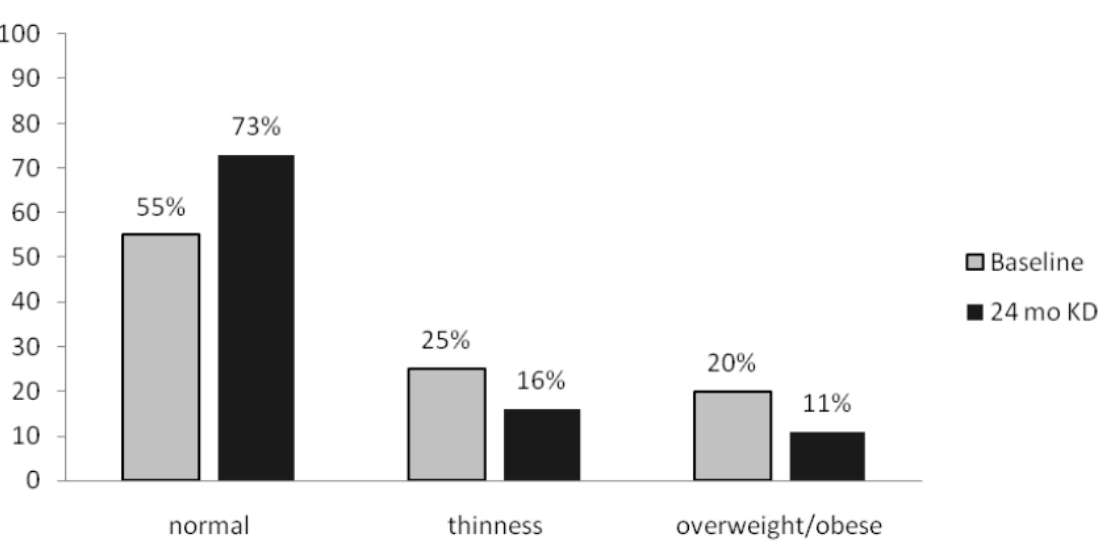
Figure 1. nutritional status according to BMI at baseline and after 2 years on KD (%). Figure 1. Nutritional status according to BMI at baseline and after 2 years on KD (%).